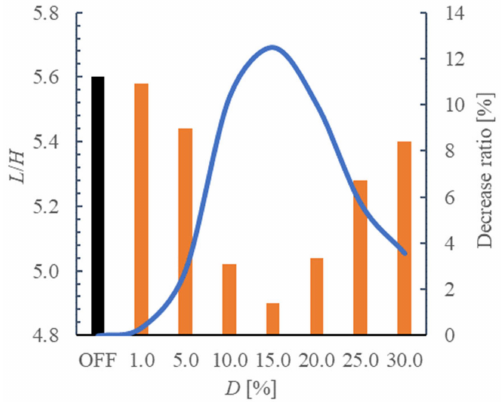
Figure 12. Reattachment length against duty ratio.